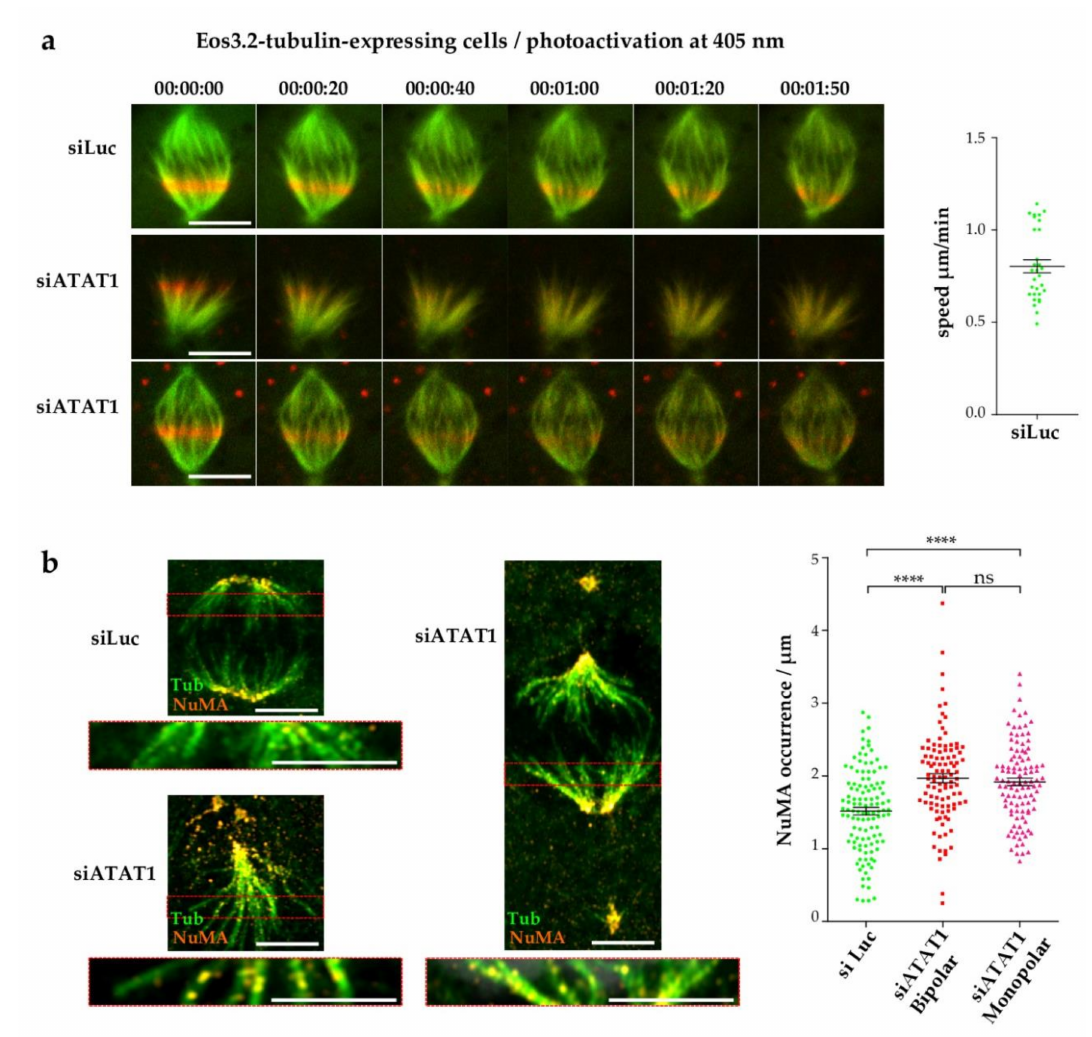
Figure 5. ATAT1 depletion perturbs the MT spindle flux and induces MT breaks. ( a ) Eos3.2-tubulin-expressing LLCPK1 cells were transfected for 48 h with siRNAs directed against luciferase or ATAT1 . A defined region, close to the chromosomes of mitotic cells, was photoactivated at 405 nm and images were acquired every 10 s. Sequential and representative images are shown. Scale bar is 9 µ m. Flux speed of siLuc cells was estimated by measuring the shortening of the distance from the centrosome to the middle of the red photoactivated tubulin signal, as a function of time (30 cells). Flux speed of si ATAT1 cells could not be evaluated because of diffuse signal. ( b ) LLCPK1 cells were transfected for 48 h with siRNAs directed against luciferase or ATAT1 , treated with cold for 20 min, fixed, and immunostained for NuMA and tubulin. Left panels: Representative MIP images of bipolar siLuc and si ATAT1 spindles and of an si ATAT1 monopolar spindle are shown.